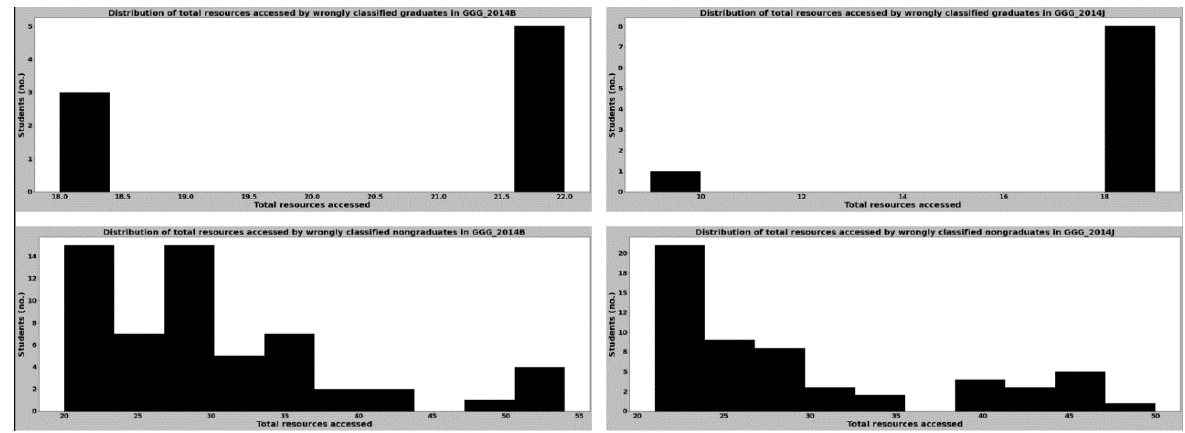
Distribution of the Total Number of Virtual Resources Accessed for Wrongly Classified Learners in Course GGG in